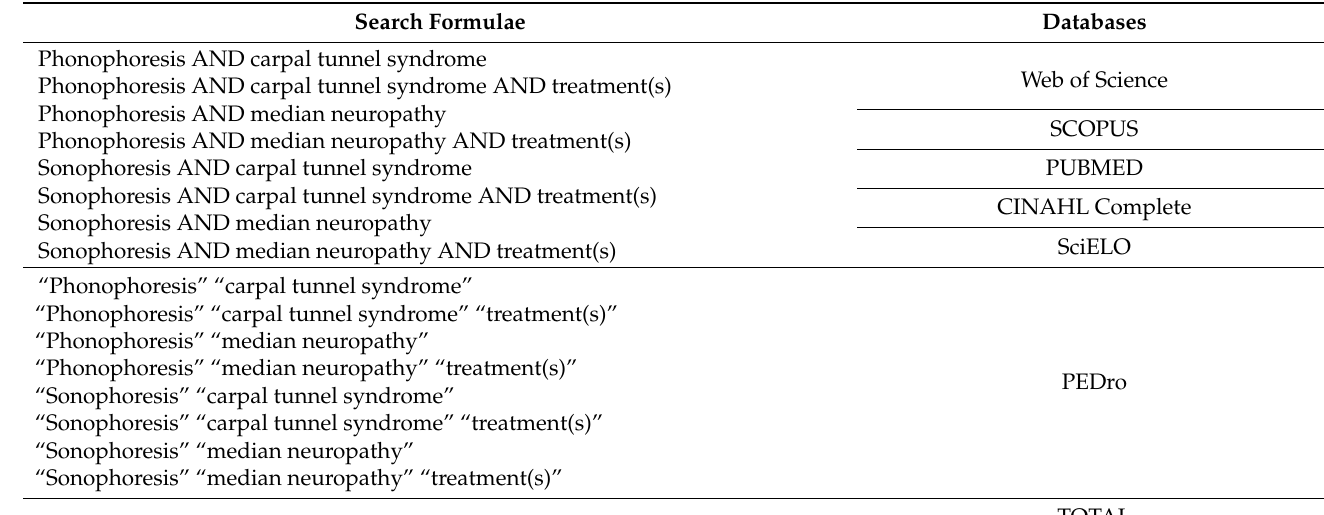
Table 1. Search strategy in the databases